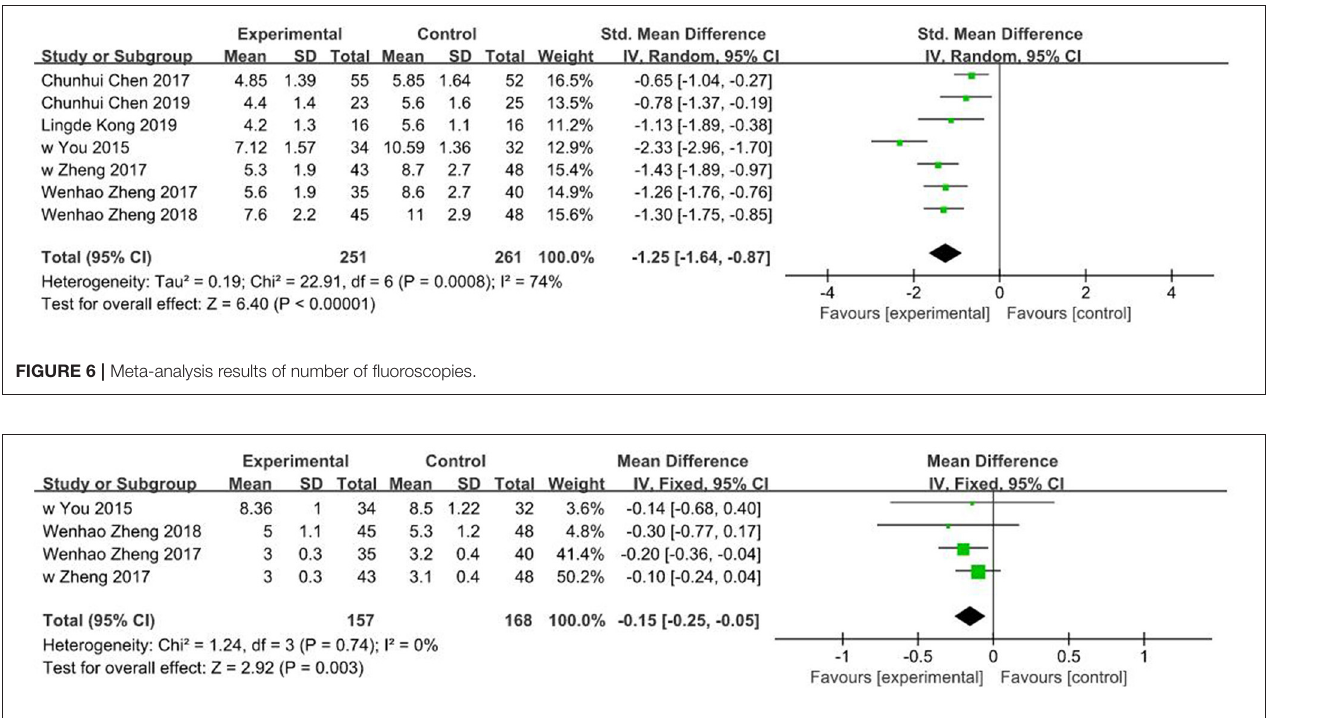
FIGURE 7 | Meta-analysis results of fracture union